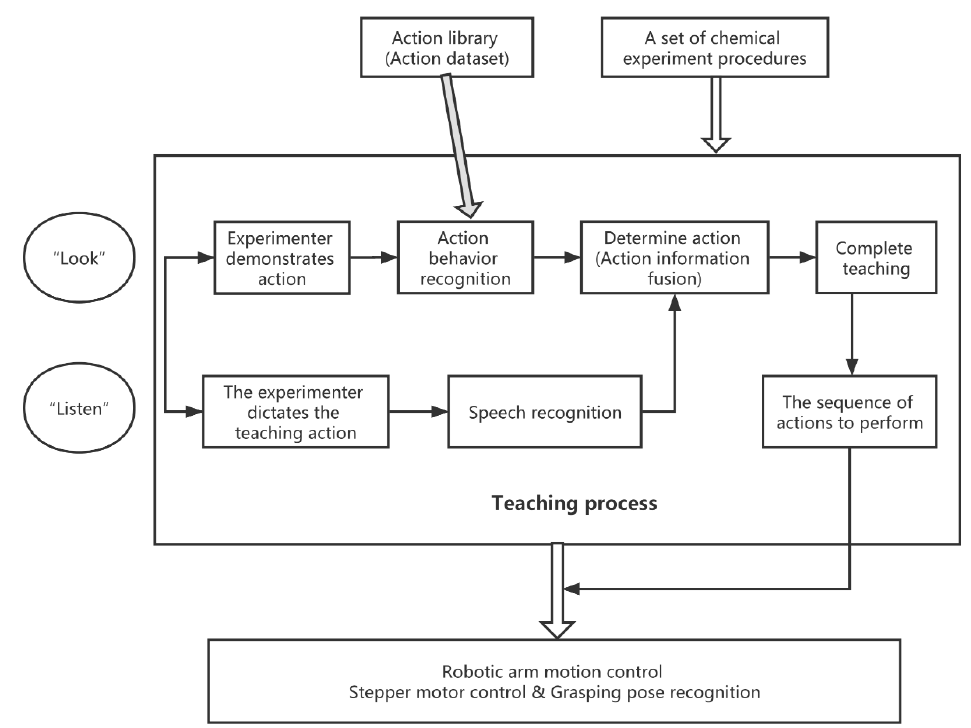
Figure 2. System function flow.